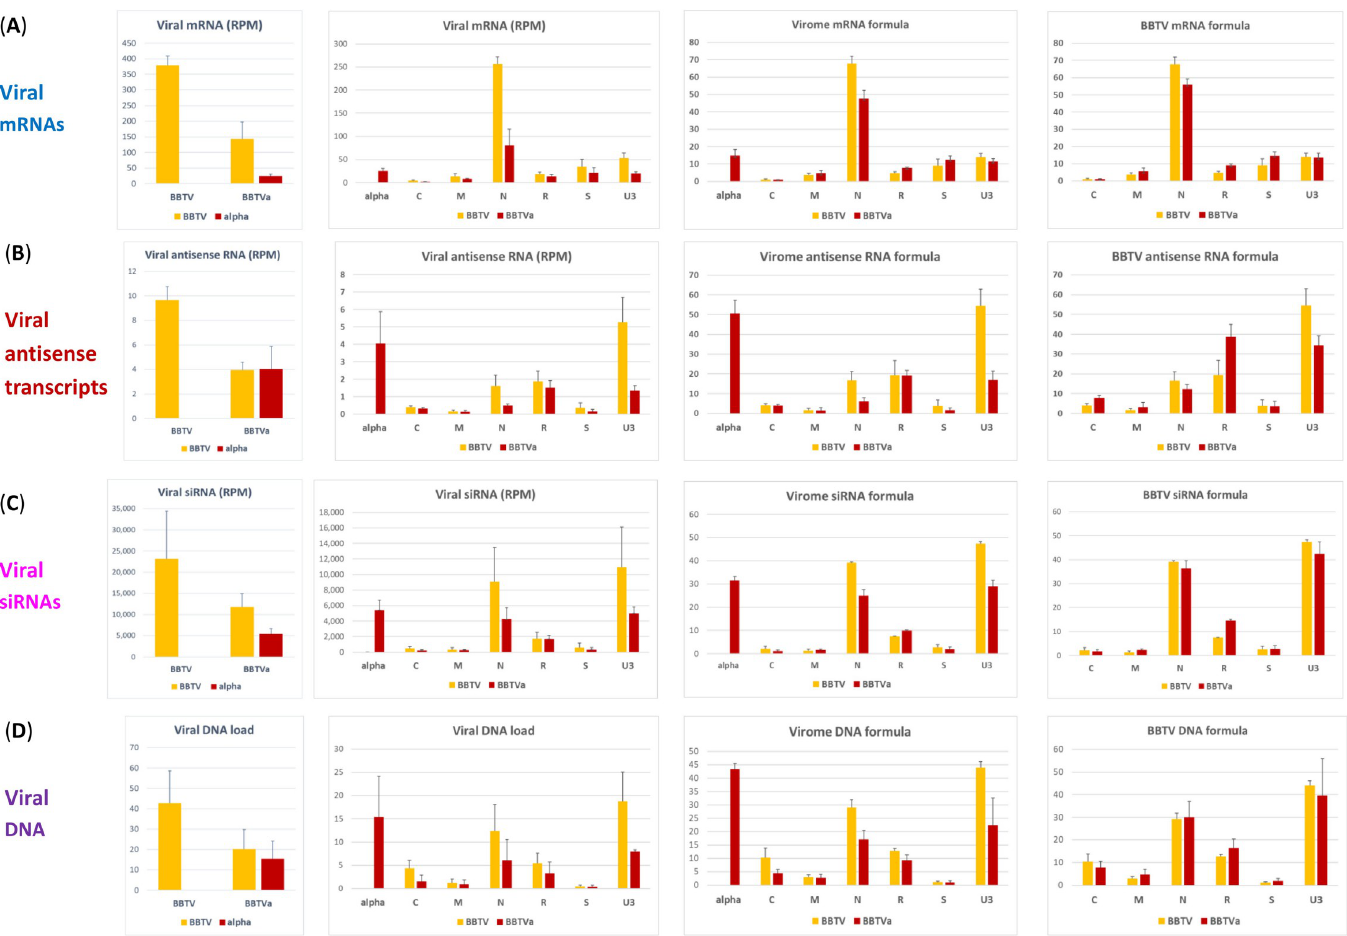
Fig 7. Impact of alphasatellite on accumulation and relative abundance of viral mRNAs, viral antisense transcripts and viral siRNAs. For each of the two conditions, i.e. without (BBTV) and with (BBTVa) alphasatellite, Illumina mRNA-seq 75 nt reads or sRNA-seq 19–25 nt reads of each of the three biological replicates (leaf tissues of three plants) were mapped with zero mismatches onto the reference sequences of all viral mRNA units and all complete viral genome components. Mapped mRNA unit sense reads, complete genome antisense reads, or complete genome sRNA sense+antisense reads were counted in reads per million (RPM) of total reads and their relative abundance (mRNA, antisense transcript, or sRNA formula) was calculated for helper virus (BBTV) and virome (BBTV + alphasatellite) in % of total. ( A-C ) Loads and formulas of viral mRNAs ( A ), viral antisense transcripts ( B ) and viral sRNAs ( C ). ( D ) Loads and formulas of viral DNA calculated by qPCR for each of the three plants (biological replicates) per condition (+/- alphasatellite). Error bars represent standard